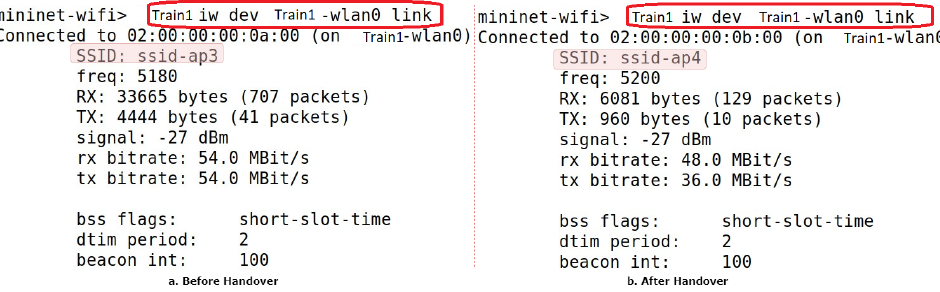
Figure 13. Connected access point for Train1 before and after